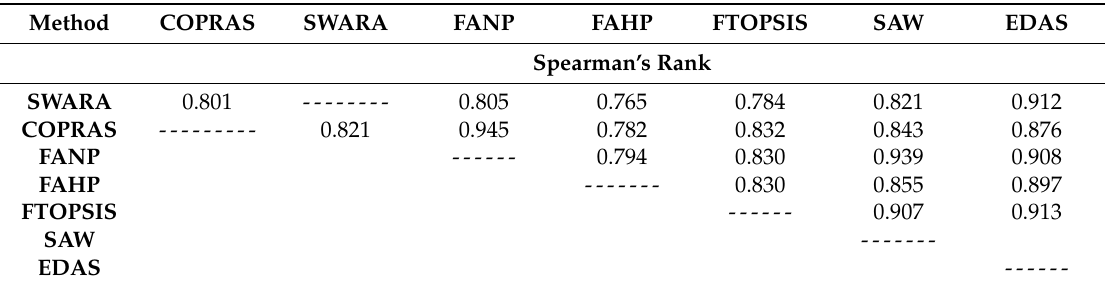
Table 7. Results of Spearman’s rank correlation coefficients.